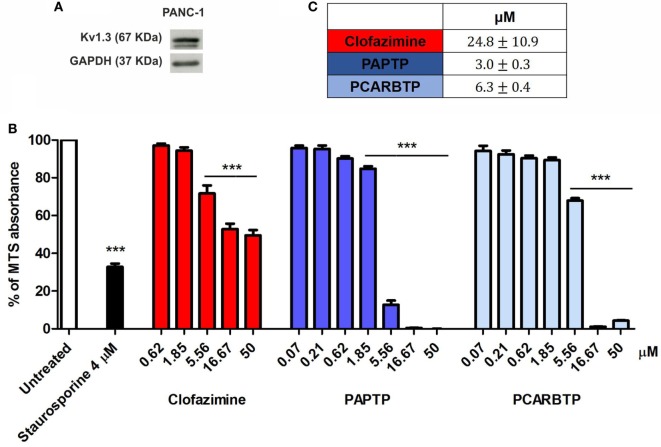
Potassium channel Kv1.3 is expressed in PANC-1 cells. (A) Kv1.3 expression was determined by Western Blot in PANC-1 cells. 60 µg of total protein extract were loaded into a SDS gel and blotted onto a polyvinylidene fluoride (PVDF) membrane. Kv1.3 band was evaluated by immunoblotting with a specific antibody. GAPDH was used as loading control. The blot is a representative image of three different observations. (B) Inhibition of mitochondrial Kv1.3 by different concentration of membrane permeant blockers resulted in a reduction of the MTS signal from PANC-1 cells. Values are reported as percentage respect to untreated sample ± SEM. All compounds were added for 24 h. Staurosporine was used as positive control (n = 3; ***p < 0.001). (C) Determination of the EC50 of the indicated compounds in PANC-1 cells treated as in (B). EC50 was determined by using Origin60 software. First, a logarithmic dose response curve was generated using MTS data and then the EC50 values were calculated using the Origin Software.